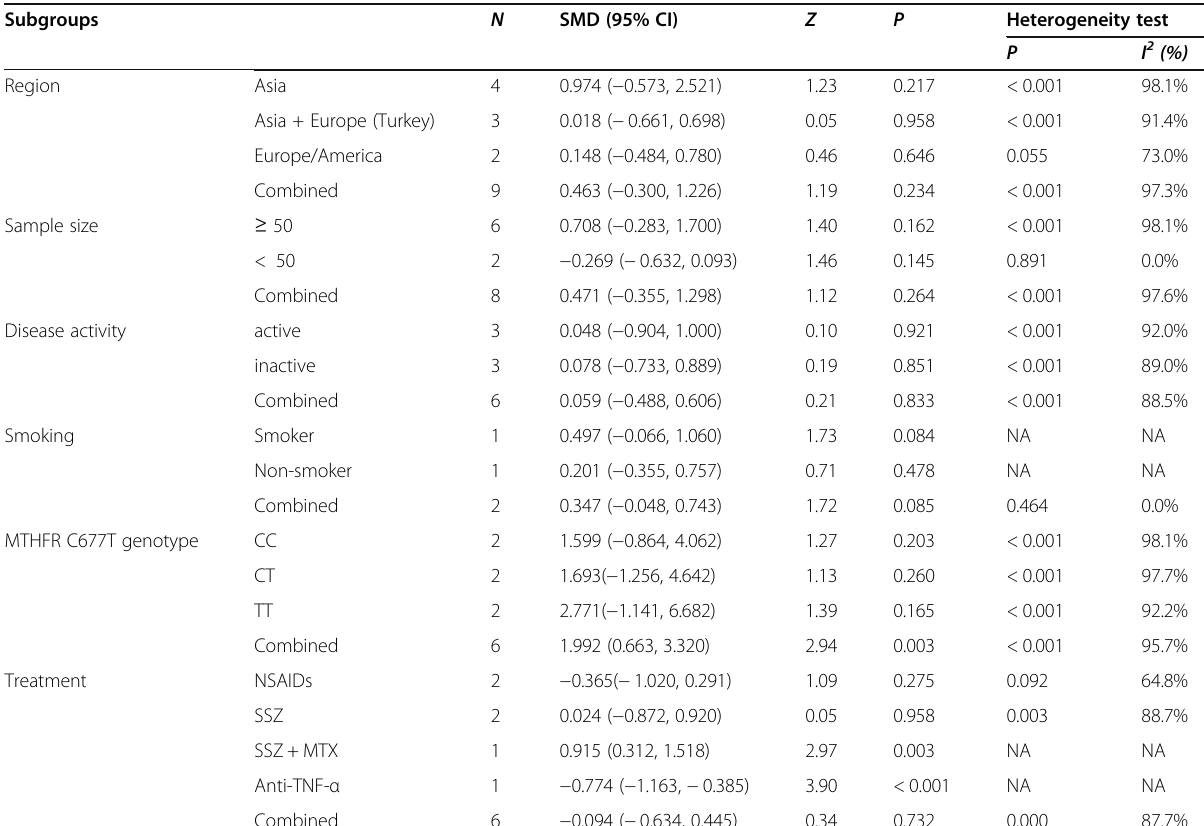
Table 3 Subgroup analysis of HCY levels in AS Subgroups Region